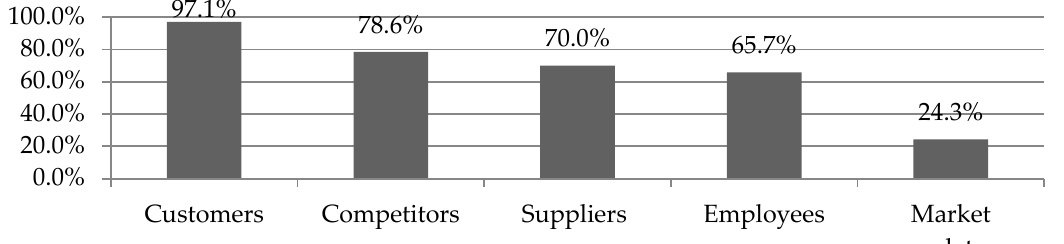
Figure 3. Frequency of used information sources (number of indications) . Source: own study based on the research on the enterprises.